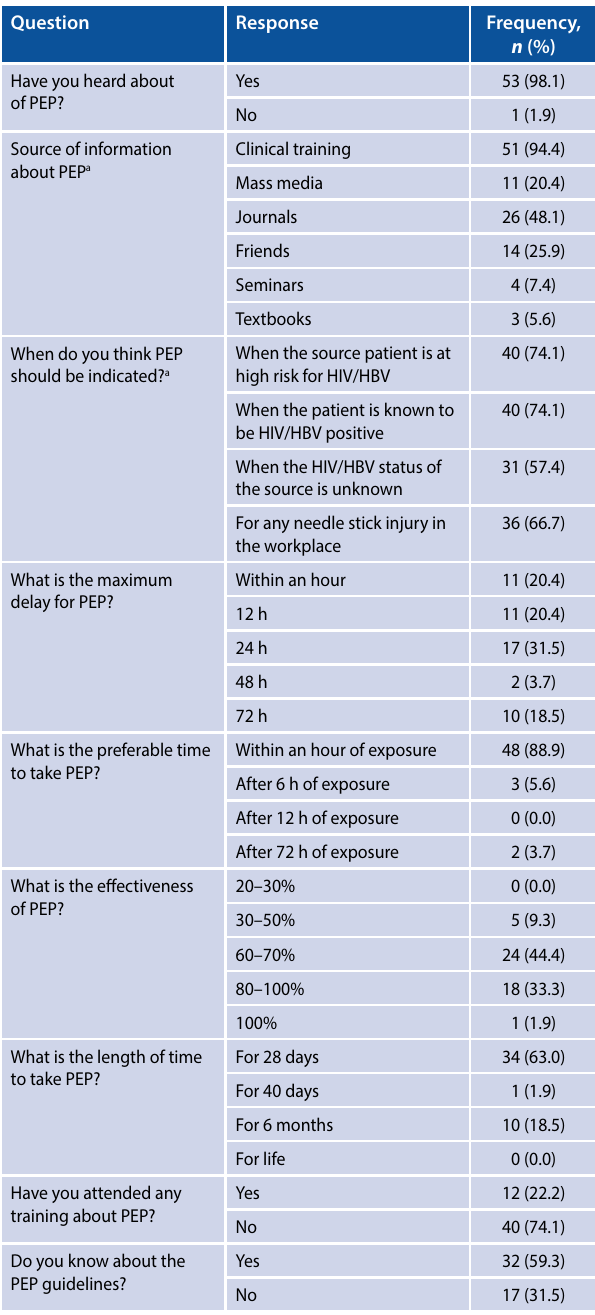
Table 2: Knowledge of dental surgeons about PEP Table 3: Attitude of dental surgeons about